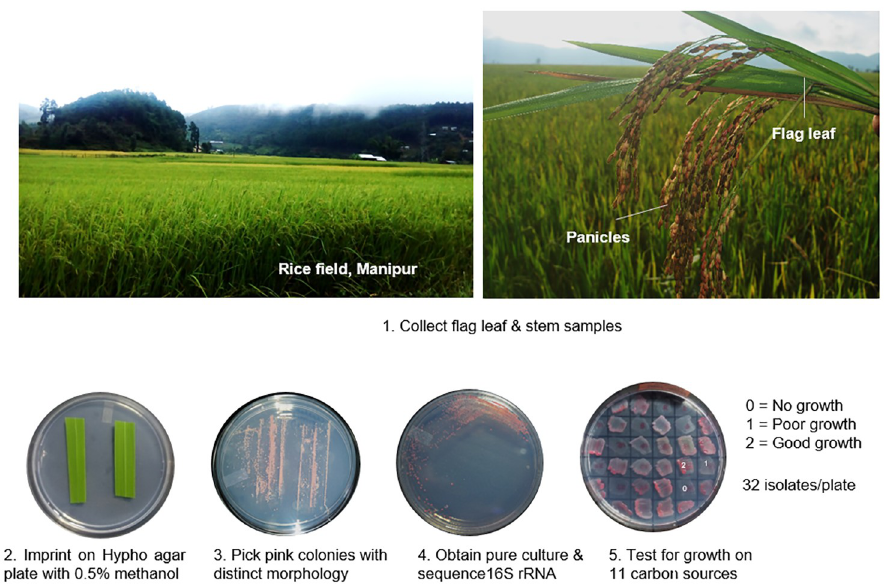
Fig 1. Overview of sampling and experimental design. We sampled phyllosphere Methylobacterium from stems and flag leaves of heading stage plants of 36 traditionally cultivated rice landraces (20 from Arunachal Pradesh and 16 from